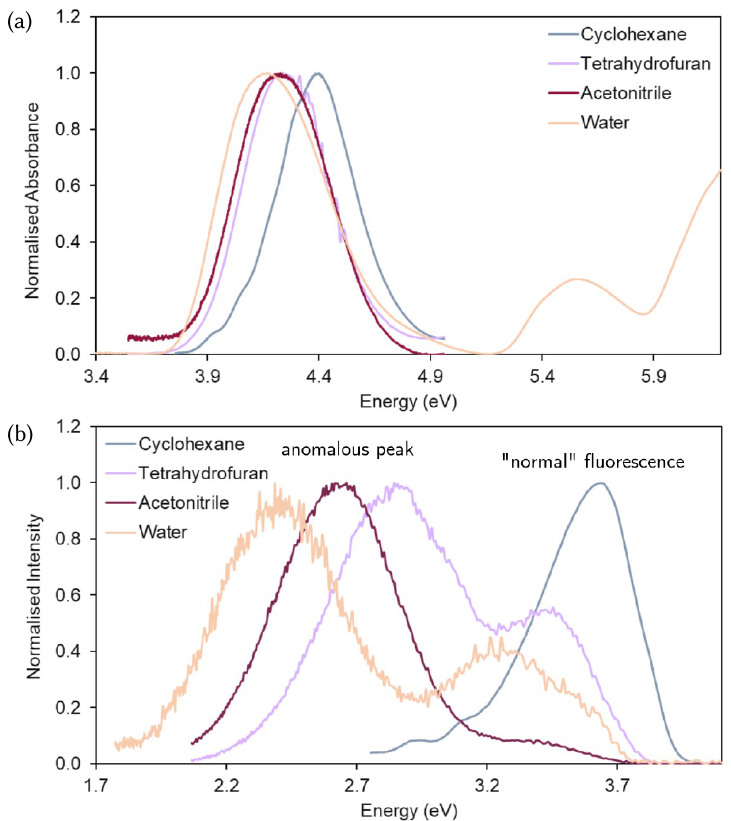
Figure 1. ( a ) Absorption and ( b ) emission spectra of DMABN solutions in cyclohexane, tetrahydrofu- ran, acetonitrile and water measured with a Perkin Elmer UV/VIS Lambda 365 spectrophotometer and a Horiba Jobin-Yvon Fluorolog-3 spectrofluorometer,